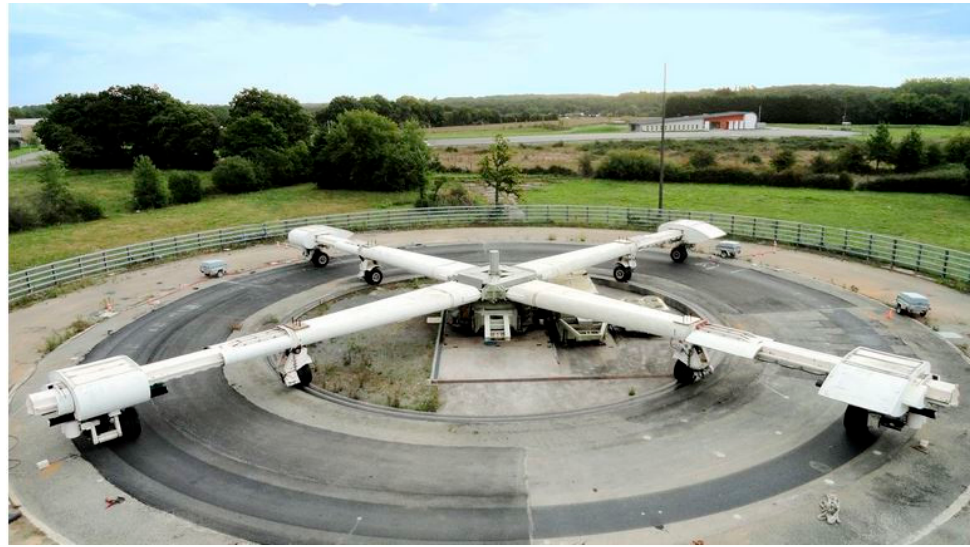
Figure 2. The pavement fatigue carousel at Univ. Eiffel Nantes [16].